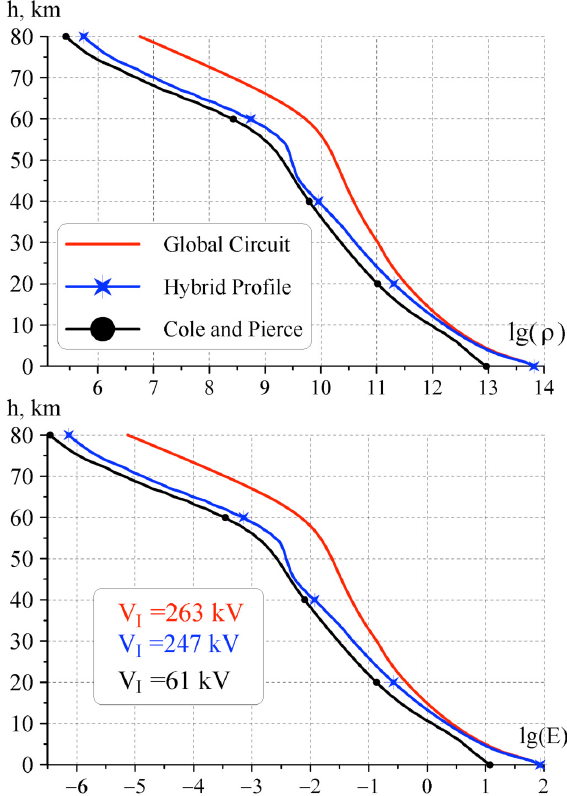
Figure 5. Altitude profiles of the air resistance (upper plot, in Ohm m) and fair weather field amplitude (in V/m, lower plot). The cor- is shown in the leg- responding value of the ionospheric potential V I end for the lower plot found in the Rycroft et al. [2007] model, for the hybrid model presented here, and for the Cole and Pierce [1965] model (CP). The value derived for the latter model is certainly far too low, whereas the small discrepancy between the red and blue values is within the range of variations with Universal Time on a particular day and within the observed day-to-day